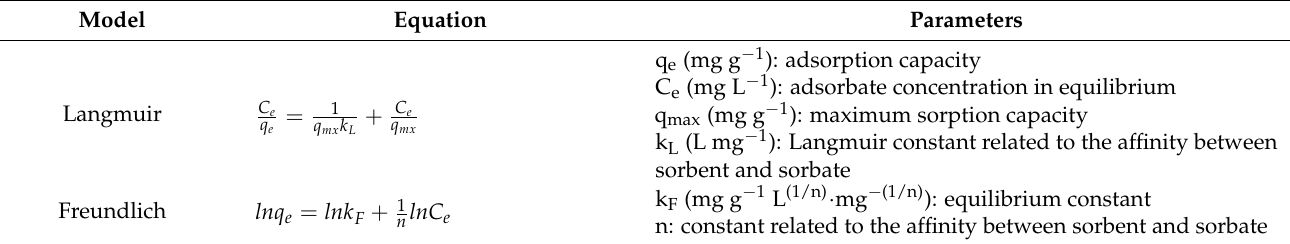
Table 6. Adsorption isotherm